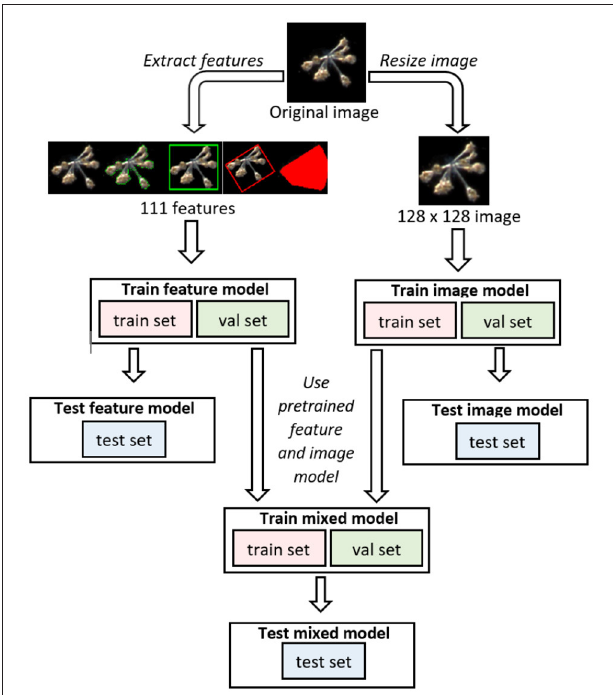
FIGURE 2 | Diagram of the three main kinds of models that we mention in our paper. Image models are convolutional networks that receive only images as input, feature models are multi-layer perceptrons (MLPs) that receive as input only features extracted from the image, but not the image per se , and Mixed models join and fine-tune Image and Feature